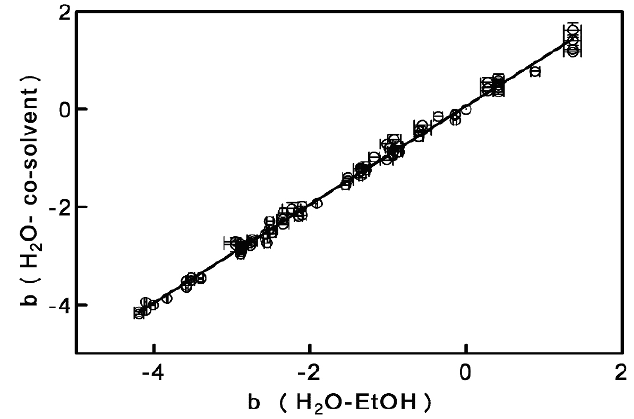
Figure 3. Intercepts of Eq. 2 for other five water - cosolvent systems (with error limits) plotted vs the intercepts for corresponding water-ethanol